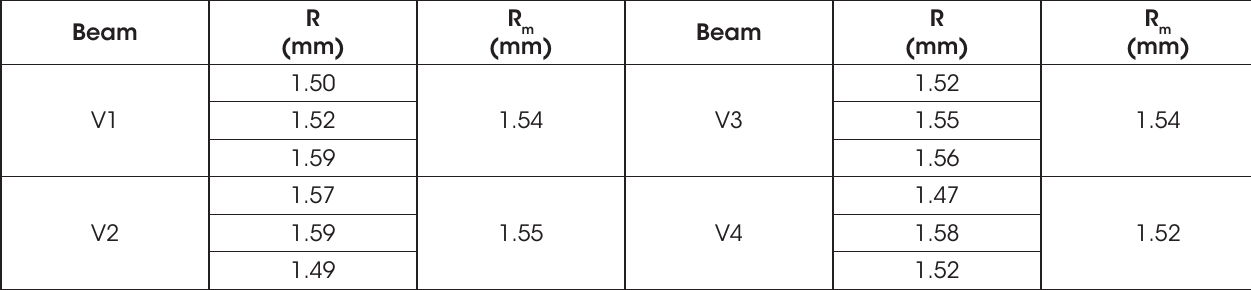
Roughness index R values and their mean R